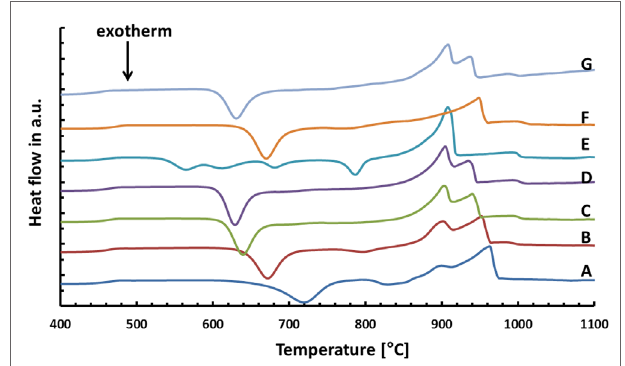
FigUre 1 | Thermal analysis of different base glasses